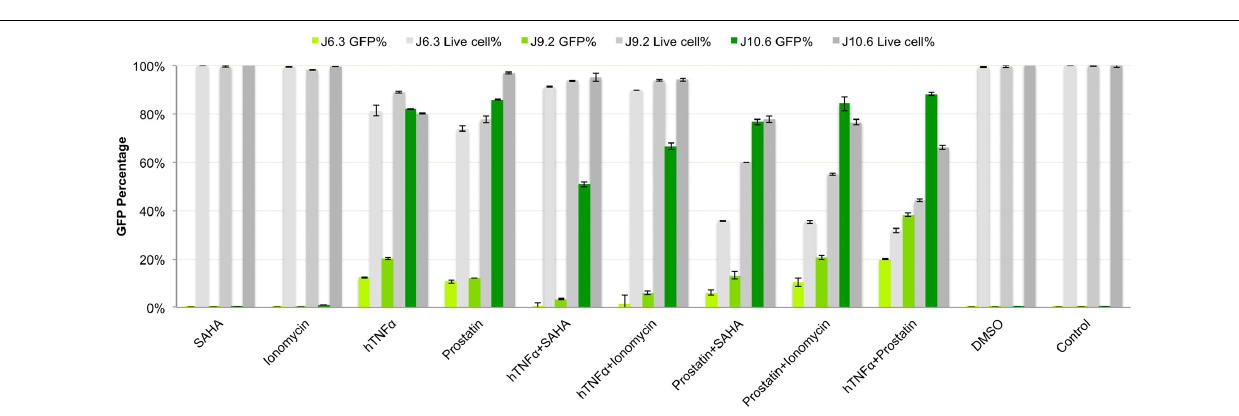
FIGURE 2 | Optimization of latency reversing reagents (LRAs). Three J-Lat cell models 6.3, 9.2, and 10.6 were used to screen for optimal LRA combinations. The doses used were: hTNF α : 10 ng/ml, Prostratin: 6 µ M, Ionomycin: 1.25 µ M, SAHA: 6.25 µ M as a single agent or in combinations. Percentage of GFP positive cells and viability were measured. J-Lat 10.6 showed maximum activation and was further used for RNA detection using the RNAflow and RNAscope. The LRA combinations hTNF- α and prostatin showed maximum activation in all three-cell model and further used as